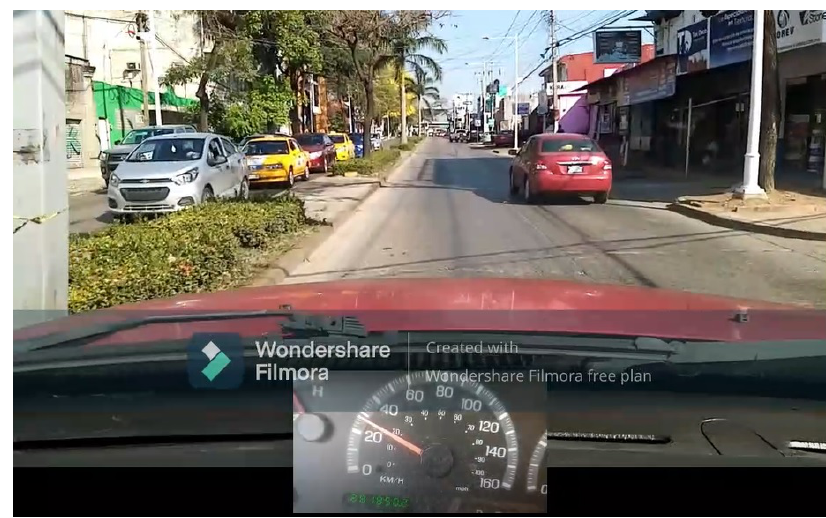
Figure 8. Road way and speed